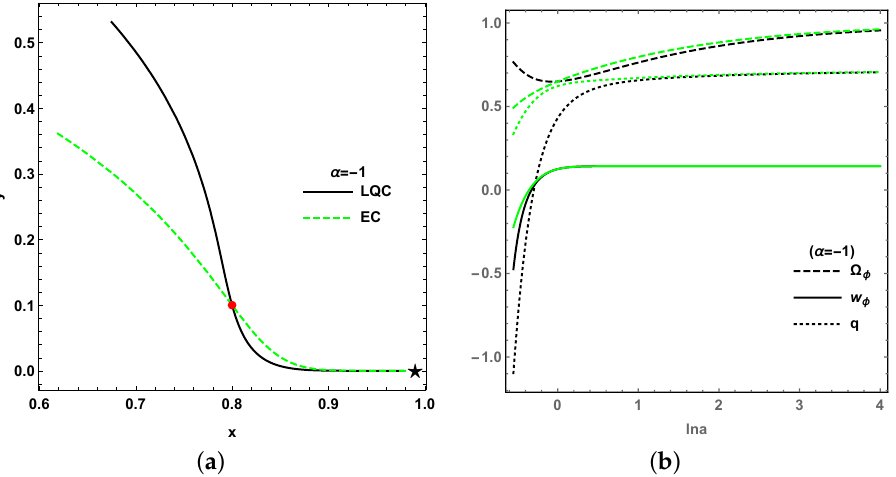
Figure 12. ( a ) The x - y phase plane projected from 4-dim system of { x , y , z , σ } for both LQC(black) and EC(green dash) around P d , corresponding to the parameters of γ k = 8 The initial points are ( 0.8,0.1, 0.1,4 ) for LQC, and ( 0.8,0.1, 0,4 ) for EC. The star stands for the final state of the evolution, while the solid circle stands for the initial point. ( b ) the evolution of the cosmological quantities of Ω φ , w φ and q for both LQC(black) and EC(green) cases around P d .